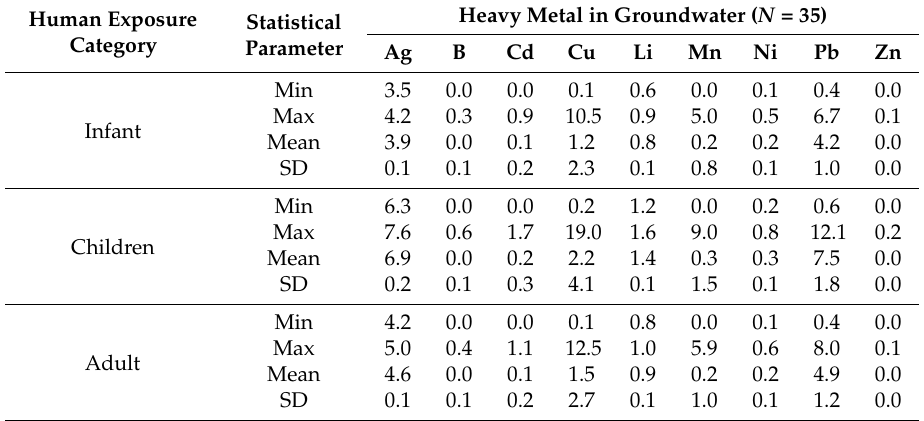
Table 6. Non-carcinogenic risk (mg/kg/day) due to heavy metals through the drinking water pathway. Human Exposure